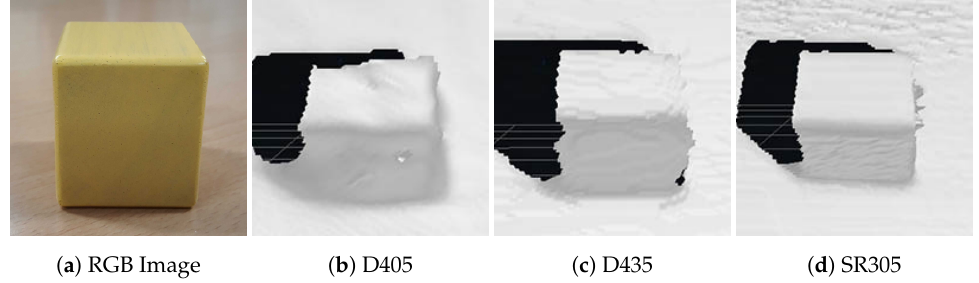
Figure 3. RGBD camera.